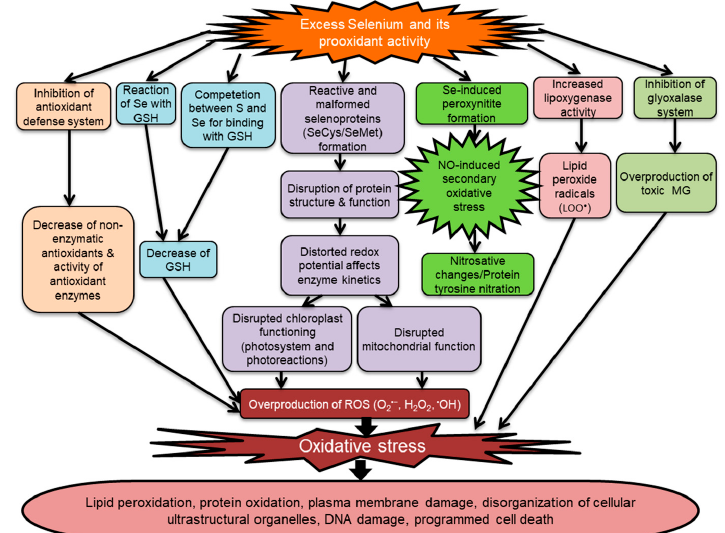
Figure 5. Selenium-induced oxidative stress and consequent damage to the plant cell. The inhibition of the antioxidant defense system by Se excess provokes overproduction of reactive oxygen species (ROS). Excess of Se can directly react with several metabolites to generate ROS. Moreover, modified chloroplast and mitochondrial reactions under toxic Se concentrations cause ROS overproduction. Selenium causes nitric oxide-induced secondary nitrooxidative stress. Increasing lipoxygenase (LOX) activity under Se exposure generates peroxide radicals (LOO • ) and inhibits the glyoxalase system causing methylglyoxal (MG) toxicity and subsequent oxidative